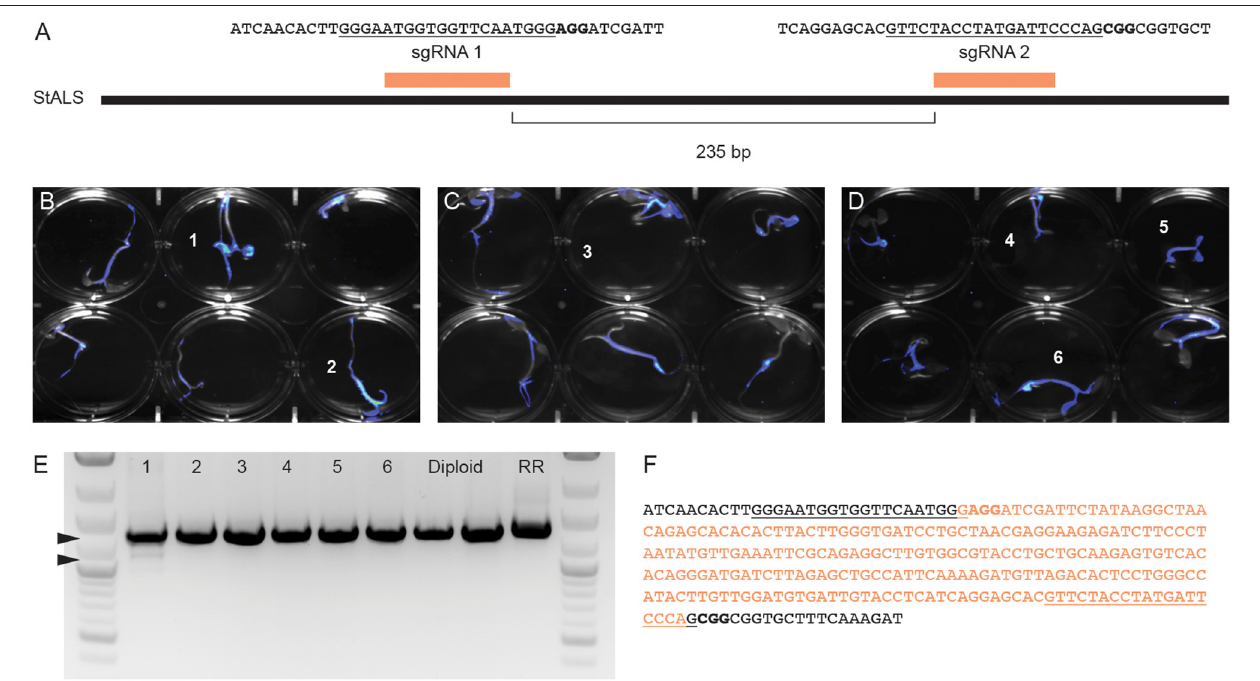
FIGURE 6 | Generating gene edits in potato seedlings. To test gene editing in diploid potato, two previously verified sgRNAs targeting StALS (A) were cloned into a single T-DNA vector and delivered via Fast-TrACC. The sequences targeted by the sgRNAs are underlined and the PAM sequence is in bold. DNA was isolated from the cotyledons of six seedlings (numbered) with the highest reporter expression (B–D) . The StALS locus was amplified (E) from these DNA samples and a deletion band (lower arrow) was observed in one of the six samples (sample 1, lower arrowhead). This deletion corresponds to the loss of the sequence between the cut sites of the two sgRNAs ( F , removed sequence in orange, sgRNA sites underlined, PAM sites